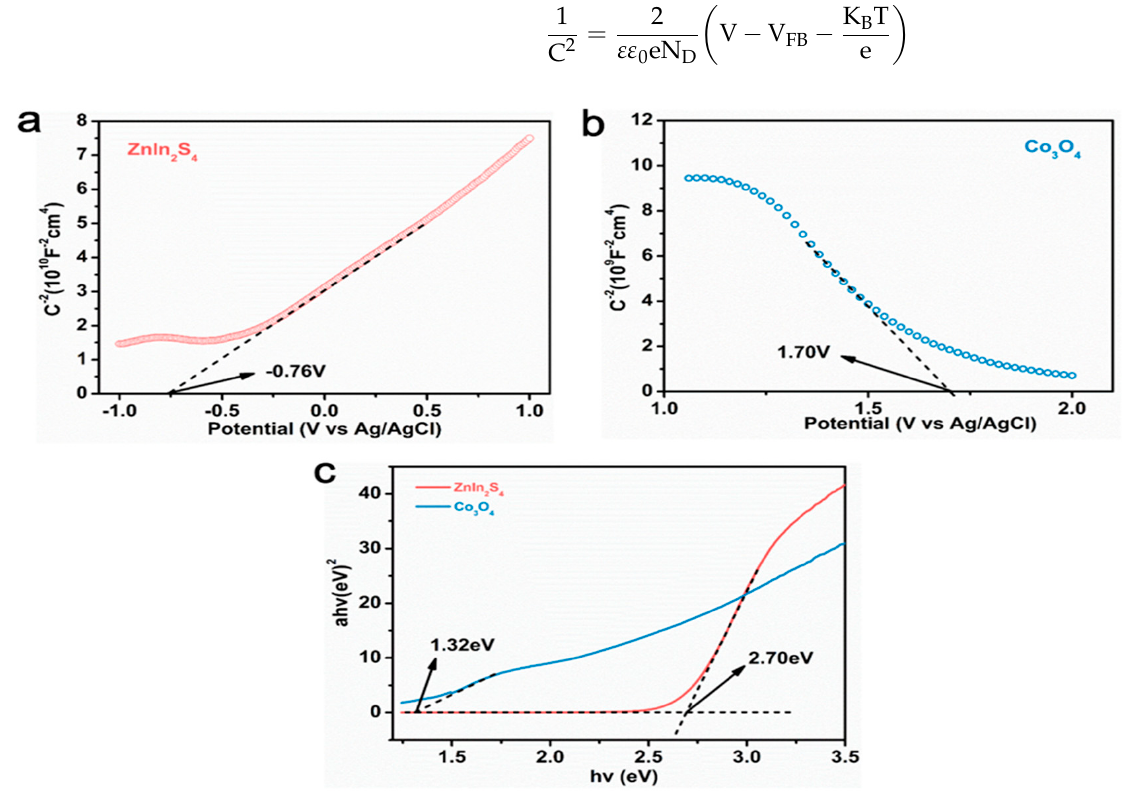
Figure 9. ( a , b ) The Mott-Schottky curve of ZnIn 2 S 4 and Co 3 O 4 ;( c ) The band gap of ZnIn 2 S 4 and Co 3 O 4 .